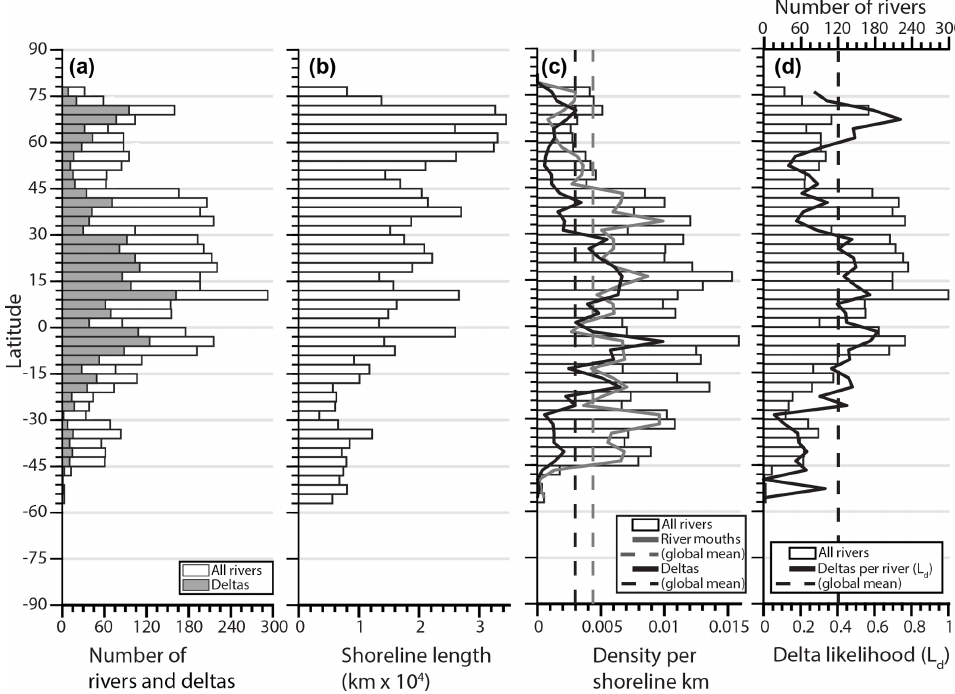
Figure 3. Histograms showing the latitudinal distribution (3 ◦ bins) of (a) the total number of rivers (white) and number of rivers with deltas (gray), (b) the total shoreline length of surveyed coastlines measured from the global shoreline database (Wessel and Smith, 1996), and (c) all rivers (including deltas) per shoreline kilometer (white bars), for which the solid gray line shows rivers with no deltas (river mouths) and the solid black line shows rivers with deltas. (d) The solid black line is the ratio of deltas per river (delta likelihood, L d ), and the white bars are the total number of rivers (including